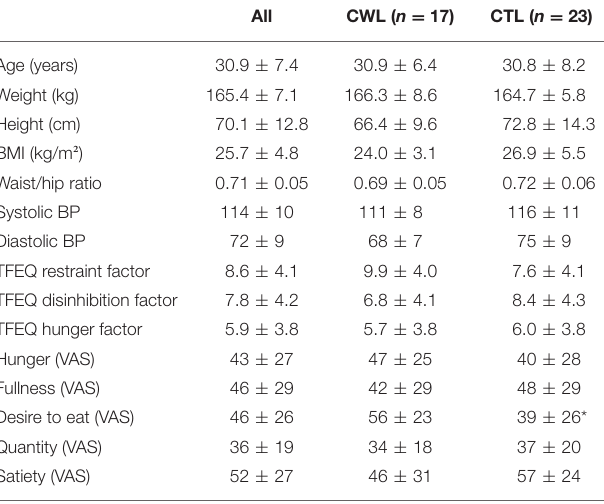
TABLE 1 | Subject characteristics, Three Factor Eating Questionnaire (TFEQ) scores and pre-trial VAS scores: CWL vs. CTL groups. All